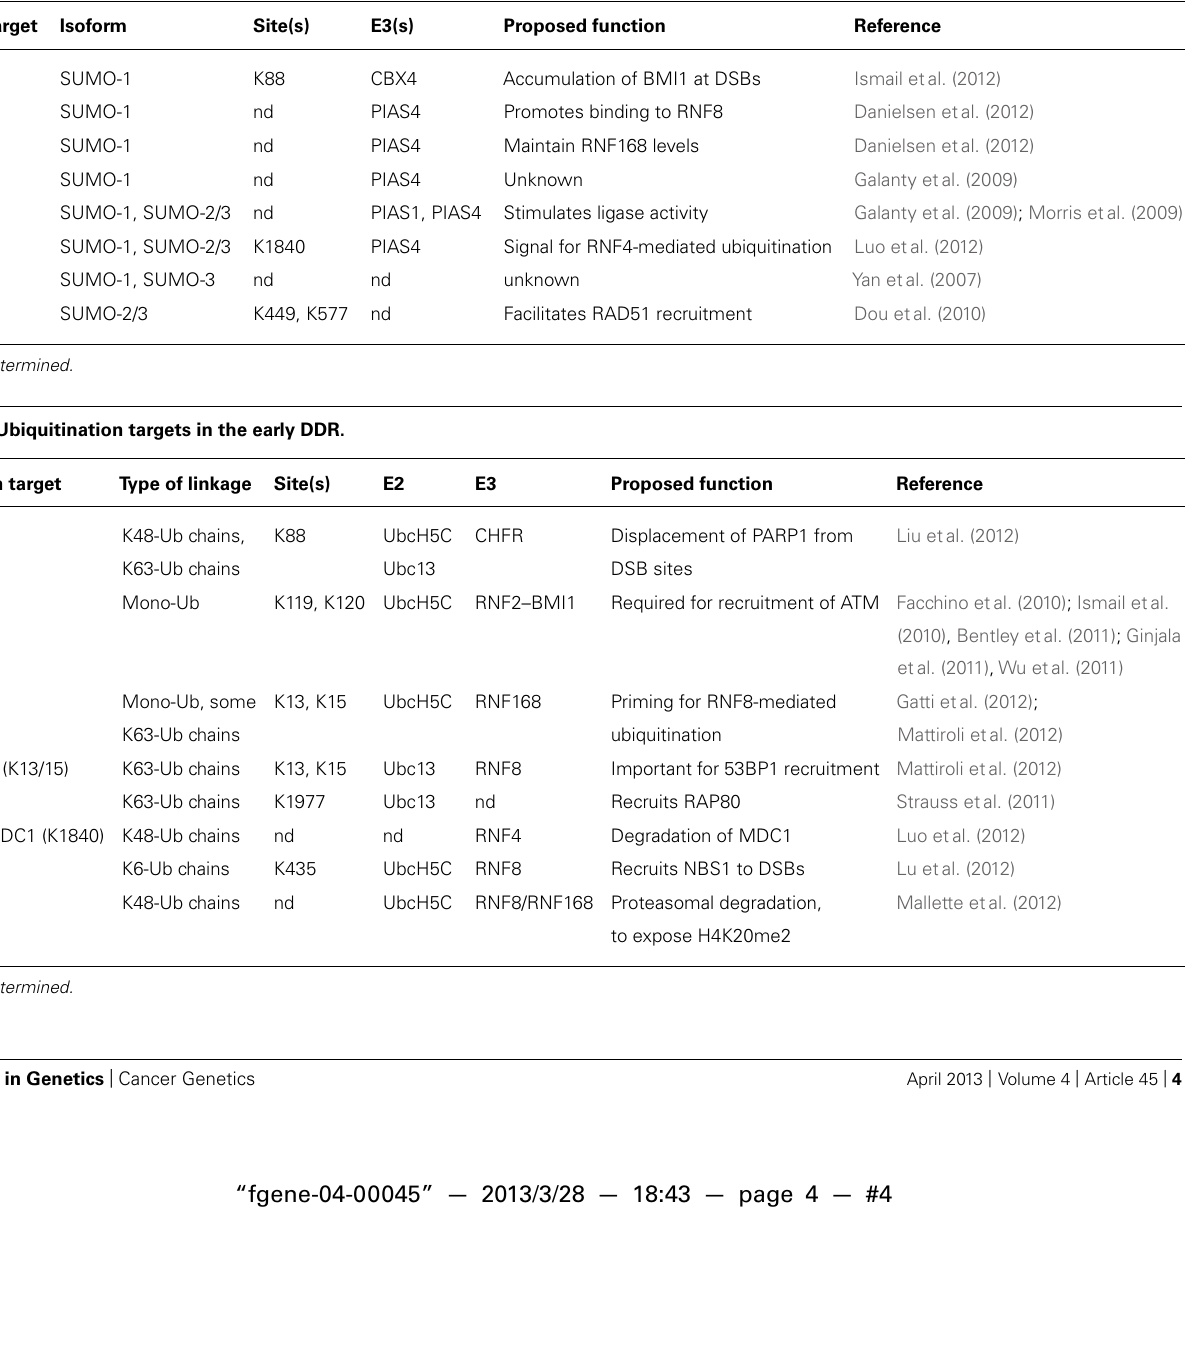
Table 1 | Sumoylation targets in the early DDR.